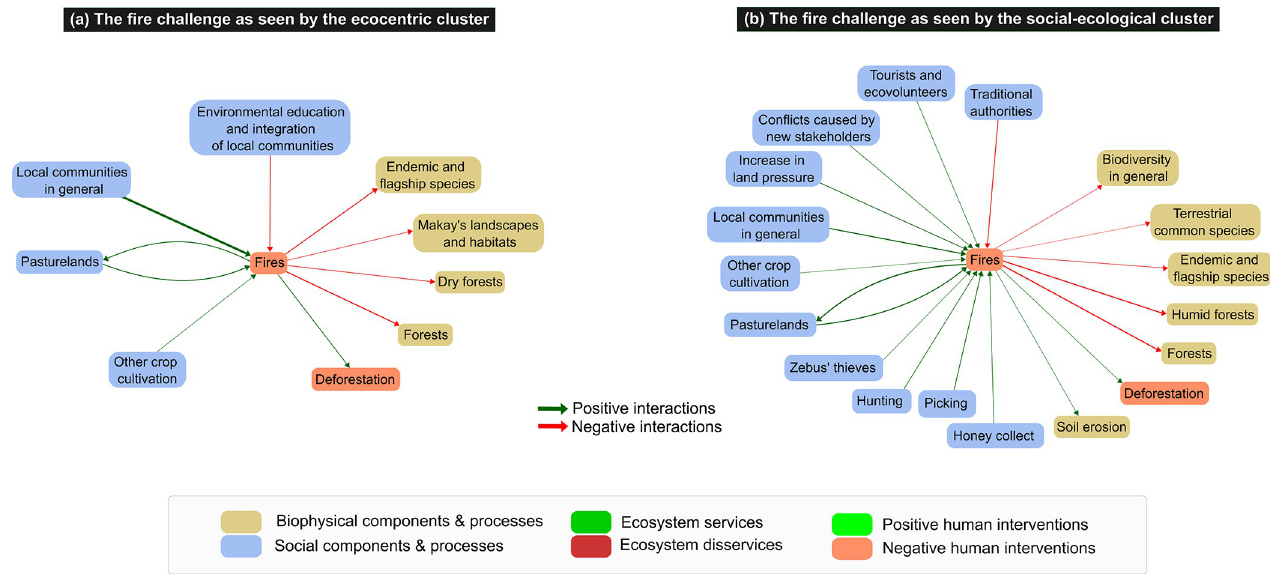
Fig 7. Group cognitive maps centered on fires in the Makay SES for each of the two clusters of respondents. Maps are based on the aggregation of the individual cognitive maps for each cluster and represented at the level of components. Only components linked with fires are represented. Edges correspond to the positive (in green) and negative (in red) interactions between components, and their width is proportional to their occurrence in individual cognitive maps (only interactions cited by > 2 respondents are represented).